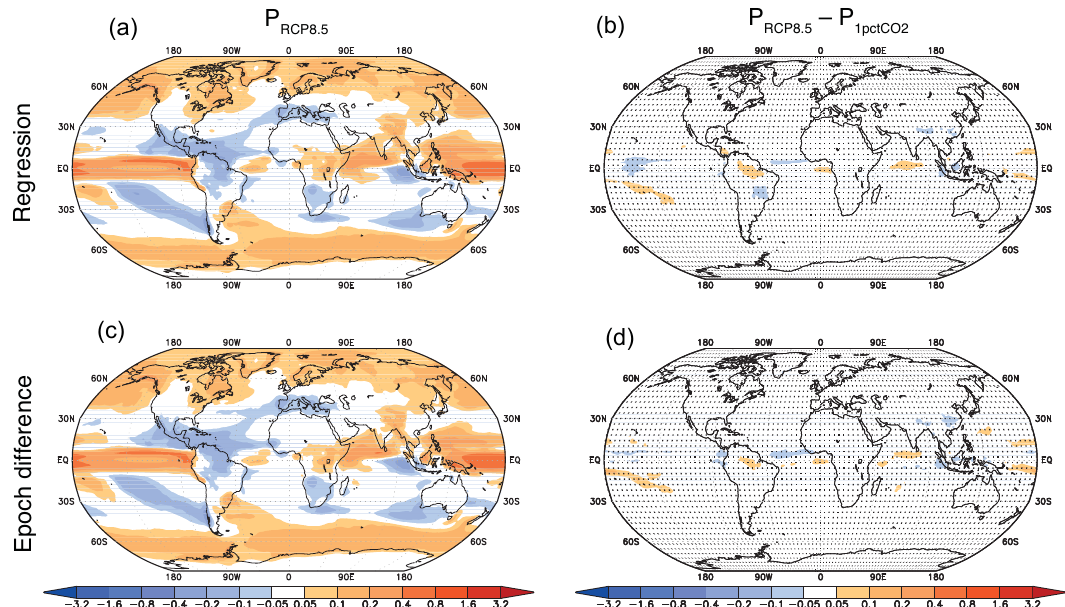
Figure 5. Absolute values (left) of and differences (right) in the precipitation scaling pattern P( x ) (Eq. 1) when different scenarios are used to construct the pattern (RCP8.5 vs. 1pctCO2). Panels (a, c) show values of P RCP8 . 5 , and (b, d) show values of P RCP8 . 5 − P 1pctCO2 (mmday − 1 K − 1 ). Panels (a, b) show results for the regression method, and bottom row shows the epoch-difference method. All values are calculated for a group 1 multi-model average for the 1pctCO2 simulation. Stippling indicates a lack of statistical significance in the pattern of differences (Sect. 2.2).